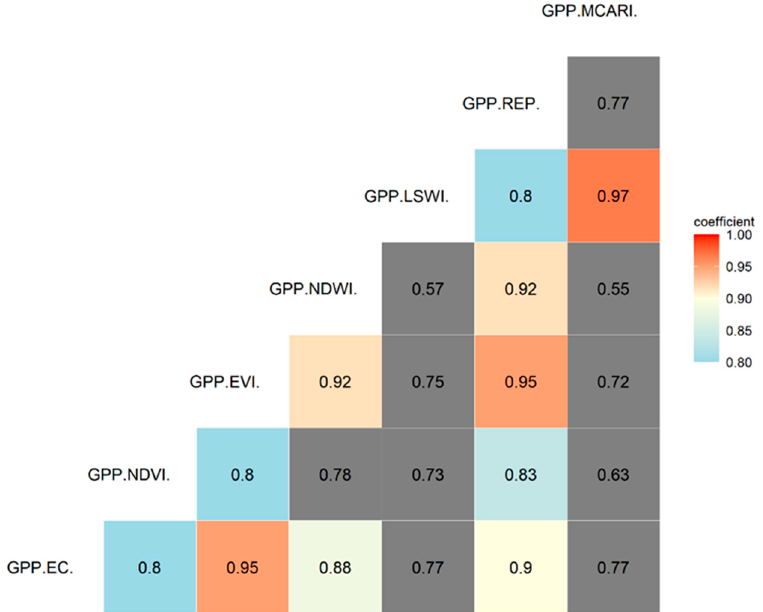
Table 2. Literature-based LUE parameter values for peatlands.